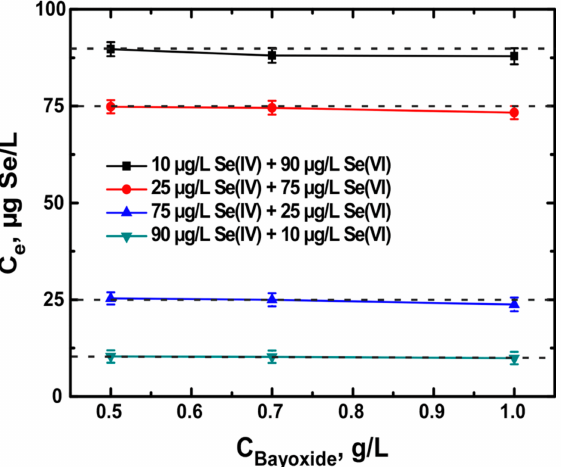
Figure 6. Equilibrium concentration of total Se, after the adsorption of selenium species mixtures in relation to Bayoxide dose. Experimental conditions: the total initial concentration of Se is 100 µ g/L, but using different ratios between the concentrations of examined Se(IV) and Se(VI) species at pH 7.3 ± 0.2, temperature 20 ◦ C and contact time 30